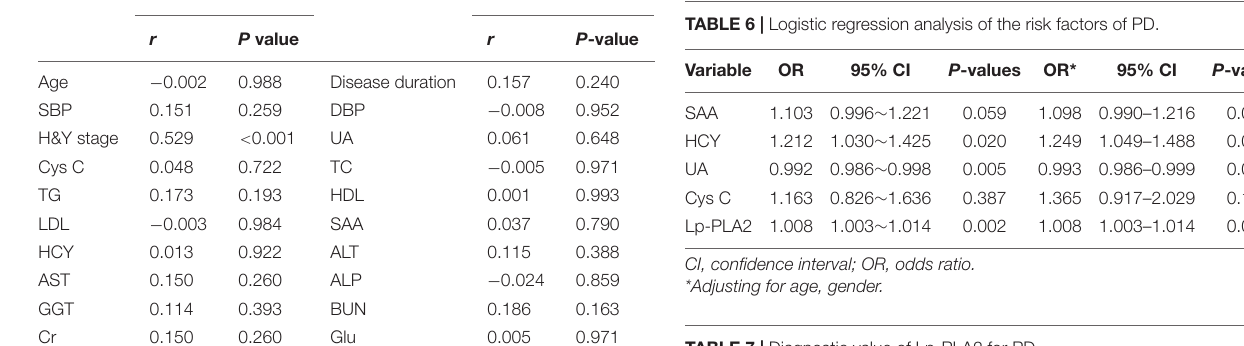
TABLE 7 | Diagnostic value of Lp-PLA2 for